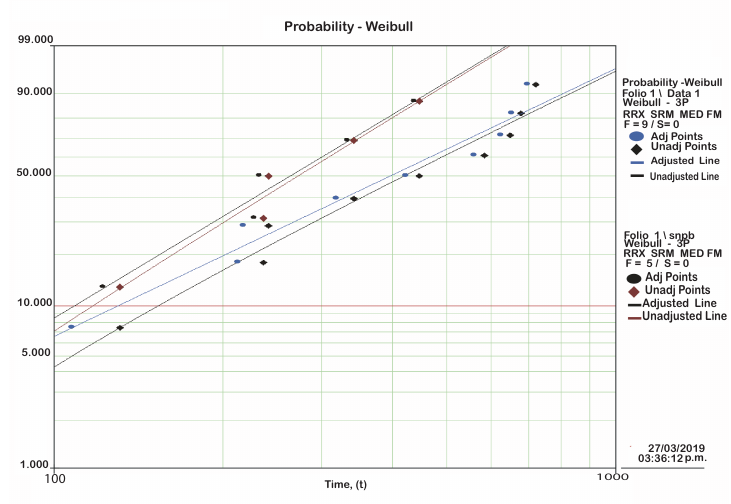
Figure 8. Unreliability graphic of the SnPb and the SnAgCu alloys. (The time is